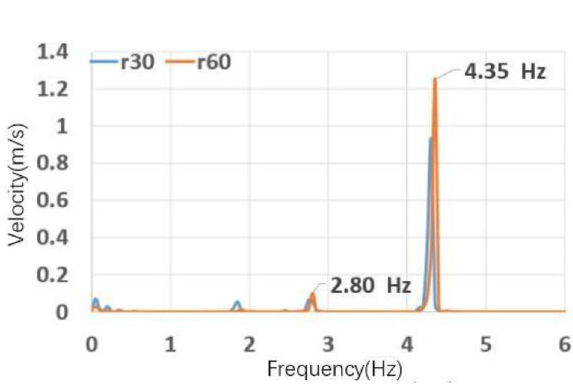
Figure 36. r30 and r60 power spectral density function.